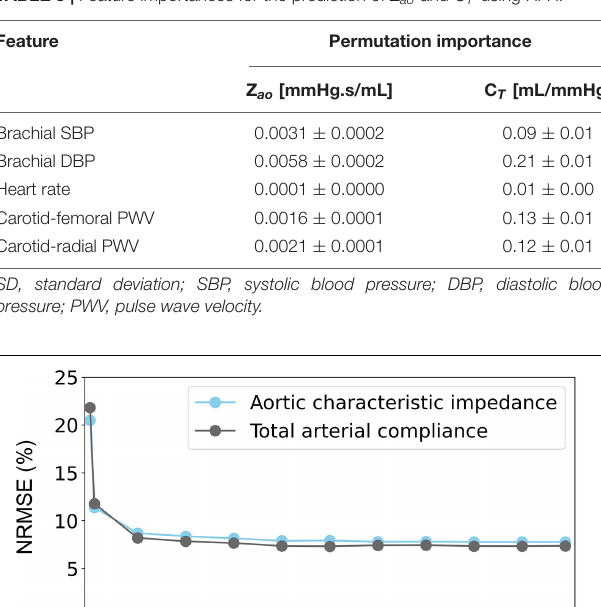
TABLE 5 | Feature importances for the prediction of Z ao and C T using RFR.